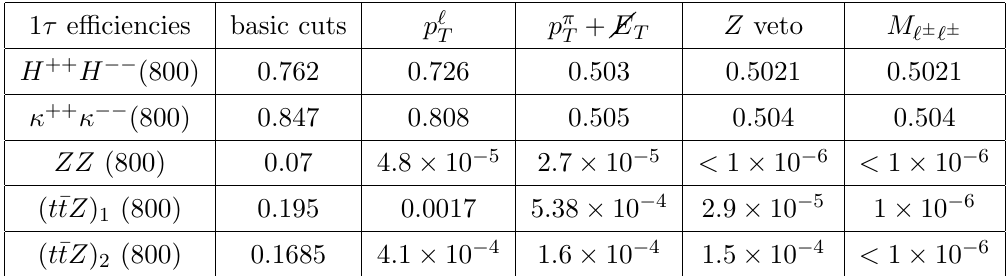
( (cid:0) ) (cid:23) (cid:28) channel at the 14 TeV LHC. We assume M